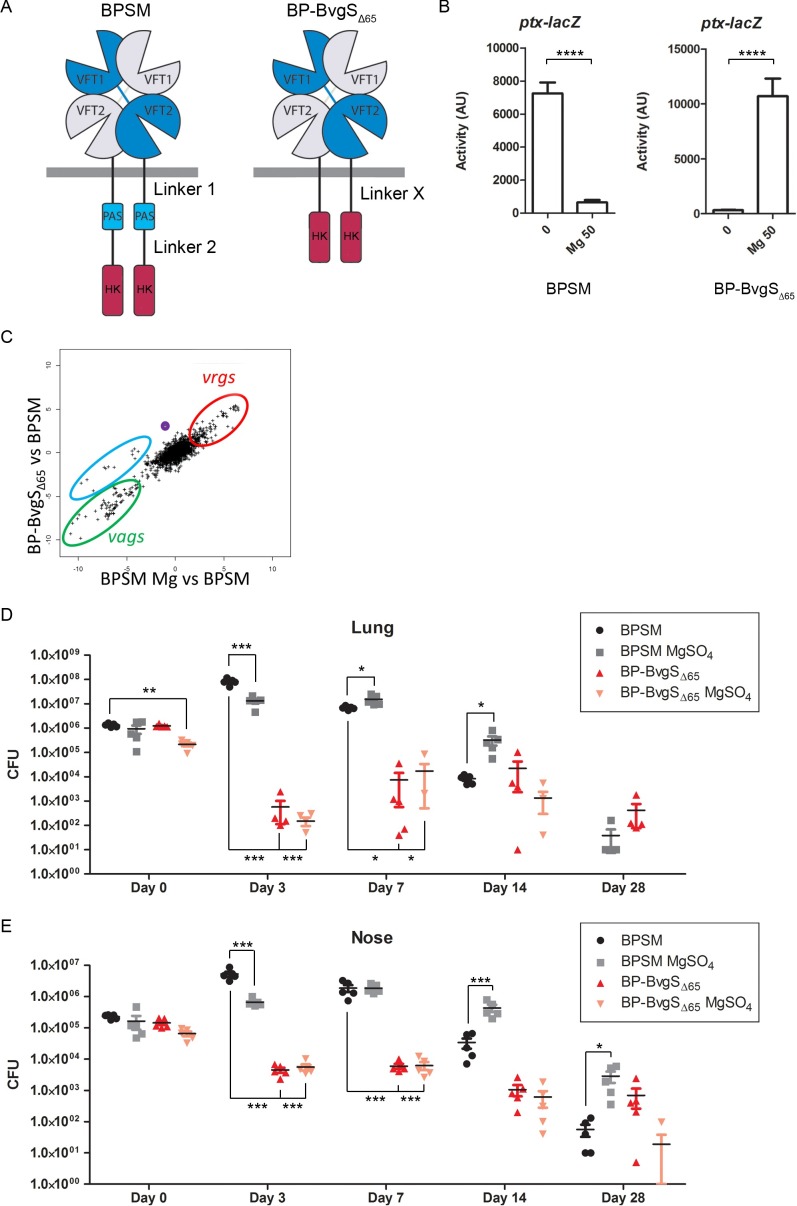
Characterization of BP-BvgSΔ65 and its colonization of the mouse respiratory tract by comparison with control strain BPSM.A. Schematic representation of wild type BvgS as found in the control strain BPSM and of the BvgSΔ65 variant. The VFT domains and Histidine Kinase (HK) domains are connected to one another with the two-helix linkers 1 and 2 and the intervening PAS domain in BPSM, or with a single two-helix linker X in BPSM-BvgSΔ65. The receiver and Hpt domains of BvgS were omitted for clarity. B. Activities of the BvgS variants as measured using the ptx-lacZ reporter system. The strains were grown in standard conditions (0) or with 50 mM MgSO4 (Mg 50). The measurements were performed at least three times, and the means and standard errors of the mean are given. Statistical analyses were performed, and significant p values are indicated (****, p<0.0001). C. Illumina RNA sequencing was performed for BPSM, BPSM grown in the presence of 50 mM MgSO4 (BPSM Mg), and BP-BvgSΔ65. The trancriptomes of BPSM grown in standard conditions and in 50 mM MgSO4 were used as the reference Bvg+ and Bvg- transcriptomes, respectively. The data are plotted as the ratios of gene expression in BP-BvgSΔ65 relative to BPSM (y-axis) versus the ratios of gene expression in modulated BPSM (denoted BPSM Mg) relative to BPSM (x-axis). Thus, genes found on a straight line starting from the origin with a slope of 1 are regulated similarly in BP-BvgSΔ65 and in modulated BPSM, while genes found above this line are expressed at higher levels in the former than in the latter. Two distinct groups of vags are circled in green and blue, with the blue oval encompassing some early vags. Most vrgs are circled in red, and bipA is shown in purple. The complete datasets of these experiments are presented in S1 Table. D and E. Numbers of colony-forming units (CFUs) recovered at the indicated time points from the lungs (D) or the noses (E) of mice infected with BPSM or BP-BvgSΔ65. Prior to inoculation, the bacteria were grown in standard or modulating conditions (addition of 50 mM MgSO4). Five mice were sacrificed at each time point for each bacterial strain. The means and standard errors of the means are shown. Statistical analyses were performed for each data point using the corresponding BPSM data point as a control. Only significant p values are indicated (***, p<0.001; **, p<0.01; *, p<0.05).